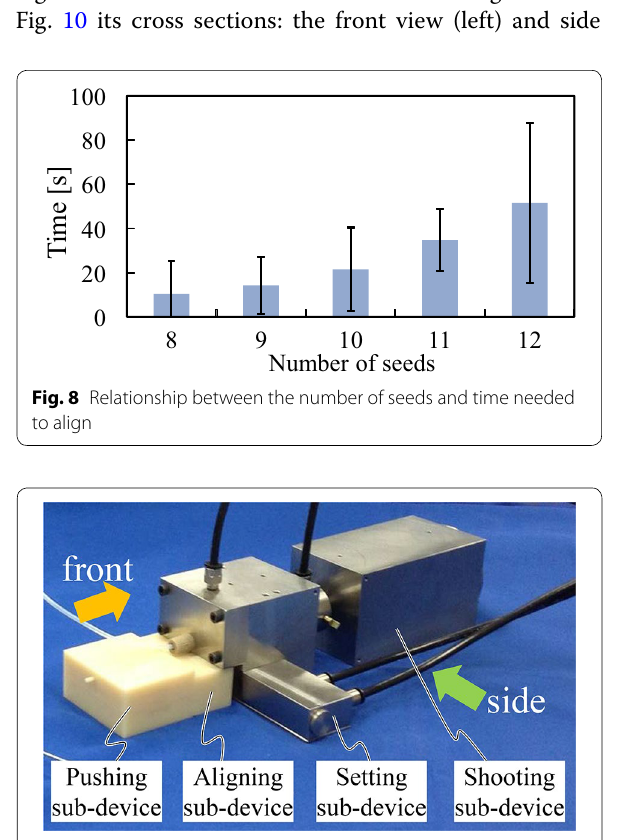
Fig. 9 Overview of the delivering unit